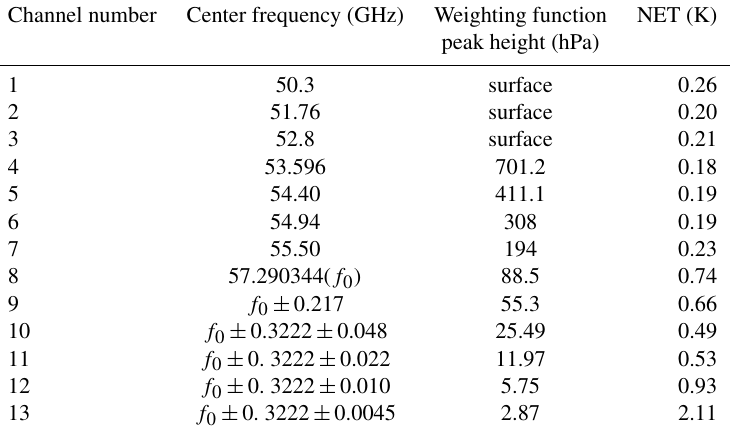
Figure 2. Global distribution of O-B from FY-3C MWTS-2 (a) channel 5, (b) channel 6, (c) channel 7, and (d) channel 8 during 03:00– 15:00UTC 1 July 2014. Table 1. Channel characteristics of FY-3C